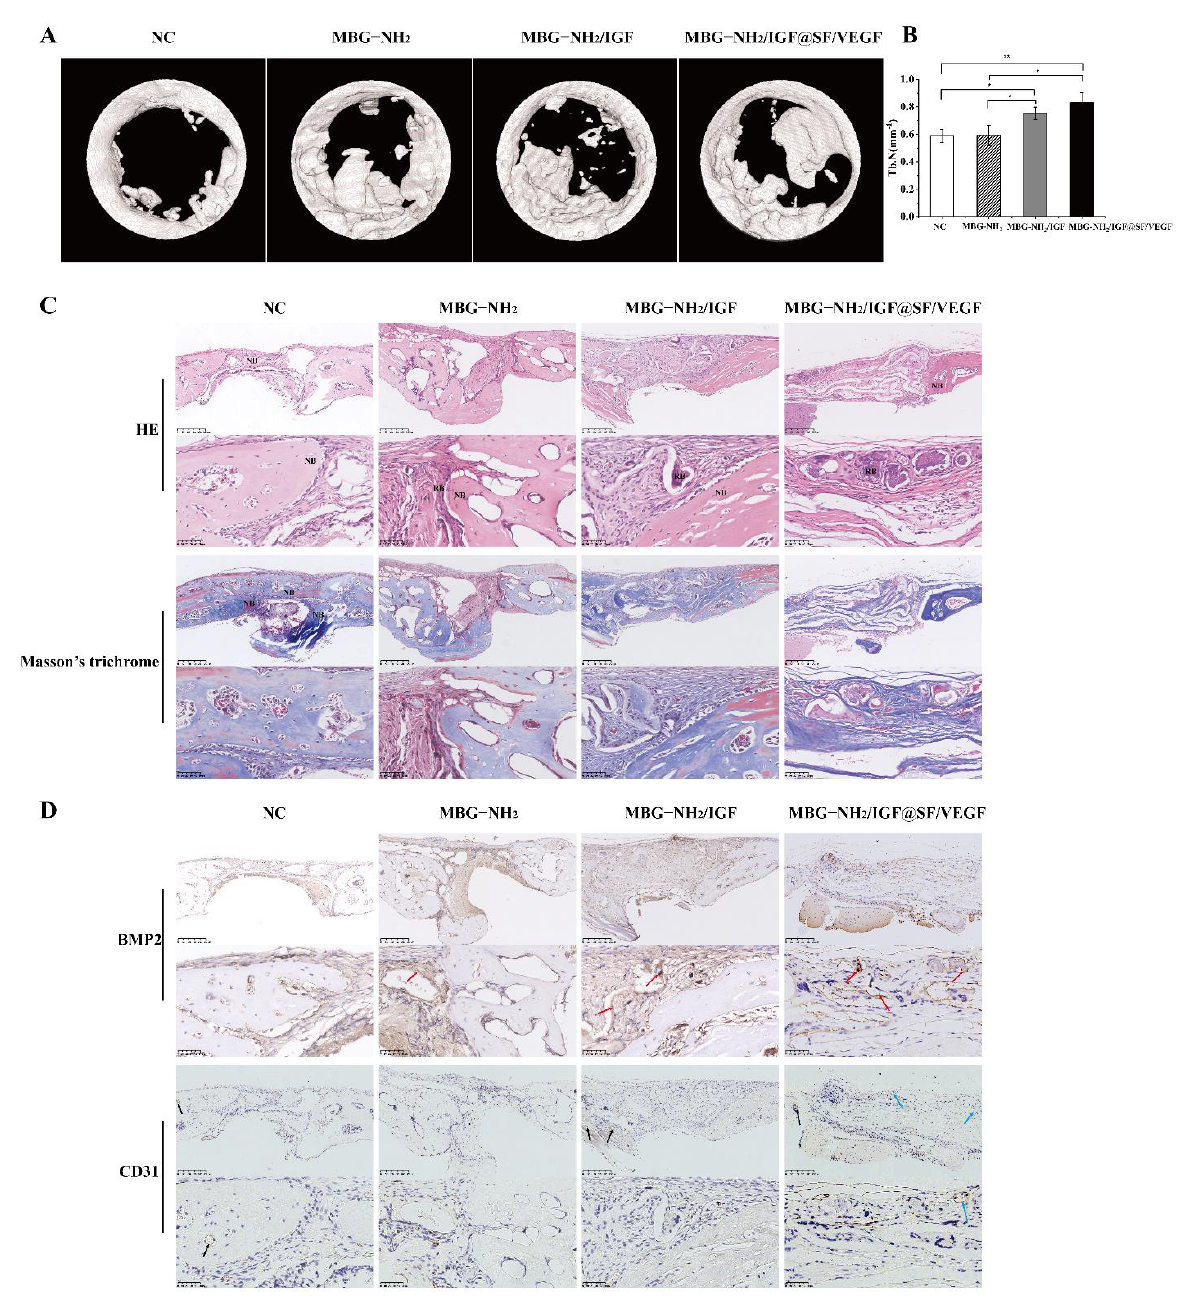
Figure 6. Bone repair ability evaluation of MBG-NH 2 , MBG-NH 2 /IGF and MBG- NH 2 /IGF@SF/VEGF scaffolds in vivo . ( A ) Micro-CT imaging analysis of skull defects in mice after 4 weeks of scaffold transplantation. NC: negative control. ( B ) Tb.N analysis of new bone. ( C ) Histological analysis of skull defects in mice after 4 weeks of scaffold transplantation; HE (top two lines) and Masson’s trichrome (bottom two lines) staining are shown. Scale bars in upper line in HE and Masson’s trichrome staining represent 250 µ m; scale bars in the nether line in HE and Masson’s trichrome staining represent 50 µ m. NB: native bone; RB: regenerated bone. ( D ) Immunohistochemical analysis of bone defect section after 4 weeks of scaffold transplantation. Bmp2 (top two lines) and CD31 (bottom two lines) staining are shown. Scale bars in upper line in Bmp2 and CD31 staining represent 250 µ m; scale bars in the nether line in Bmp2 and CD31 staining represent 50 µ m. High expression areas of Bmp2 are indicated by red arrows. Vessels in native bone are indicated by black arrows, and newly formed vessels in regenerated bone are indicated by blue arrows. Experimental data were analyzed as indicated and reported as mean ± SE. (* p < 0.05; ** p <